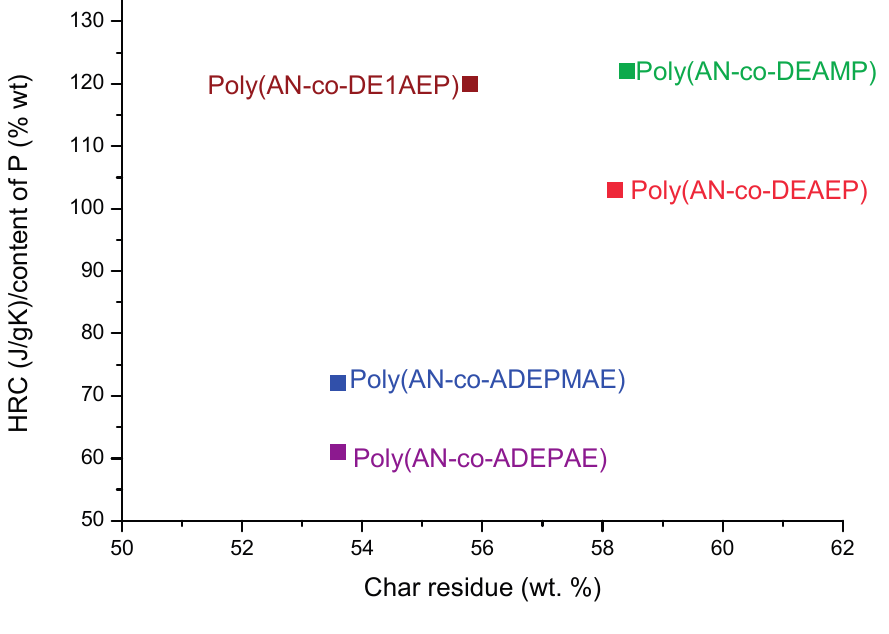
Figure 4. Ratio of HRC to content of P versus PCFC char residue for copolymers of